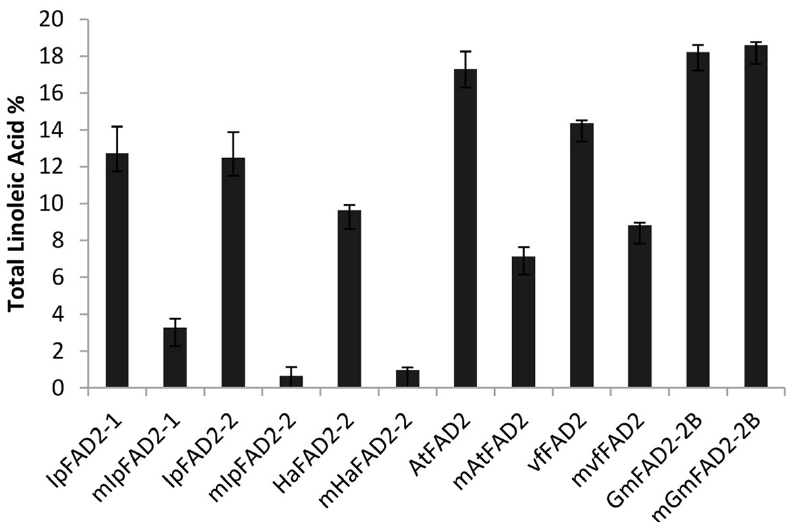
Figure 6. Total C18:2 accumulation in yeast containing FAD2 orthologs from different species. Levels of total C18:2 accumulation in yeast cells expressing plant FAD2s and the corresponding mutated form with the conserved glycine (G376, 375 or 374) substituted by cysteine. Ha, Helianthus annuus ; At, Arabidopsis thaliana ; Vf, Vernicia fordii ; Gm, Glycine max . The corresponding mutated residues are: IpFAD2-1, G376C; IpFAD2-2, G374C; HaFAD2-2, G375C; AtFAD2, G375C; VfFAD2, G375C; GmFAD2-2B, G375C. “m” in front of each protein name represents the mutated form of the corresponding FAD2. Mean ± SD; n = 3.